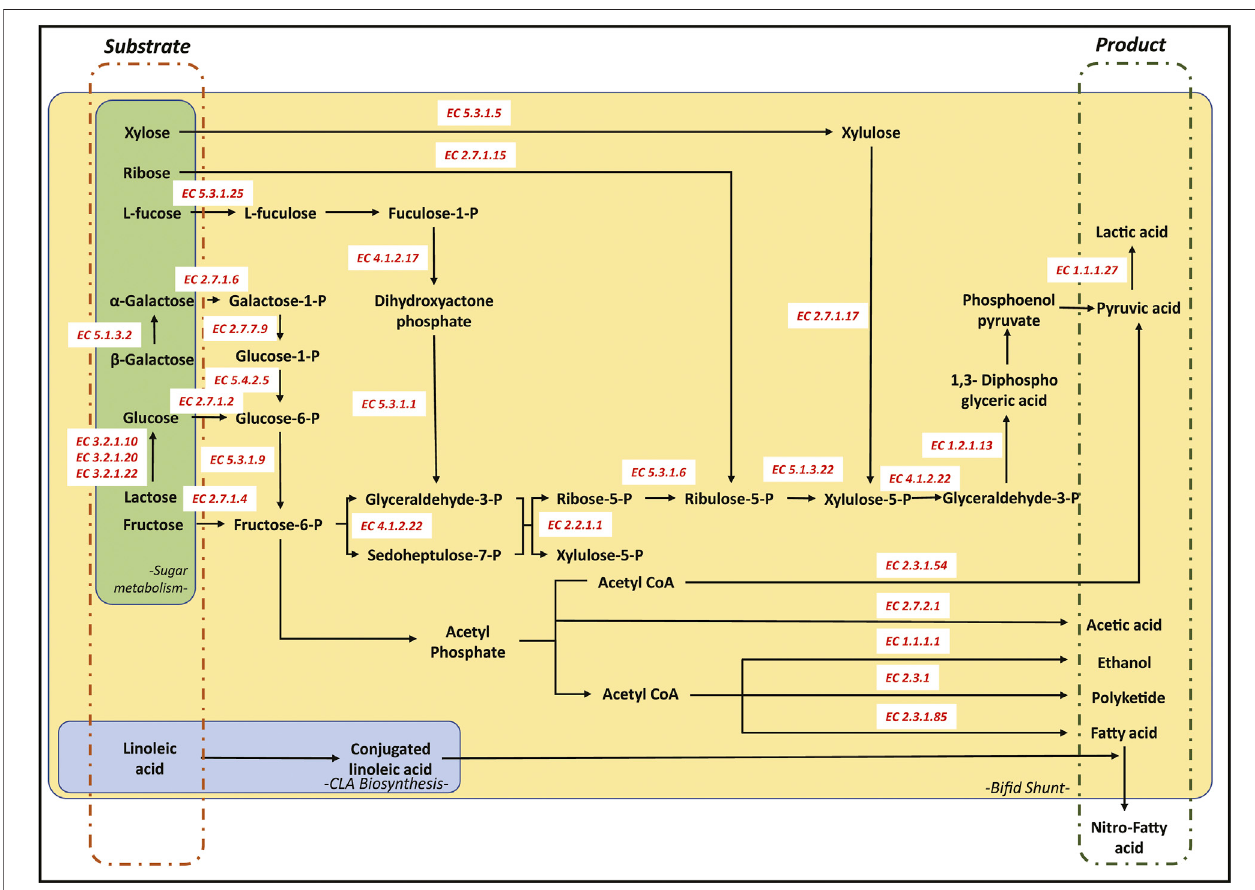
FIGURE 2 | Schematic representation of the Bi fi d shunt pathway (yellow), CLA pathway (blue) and other carbohydrate degradation pathways (green). All corresponding enzymes in the pathway were annotated using the Enzyme Commission numbers as recommendedby theNomenclature Committee of theInternational Union of Biochemistry and Molecular Biology